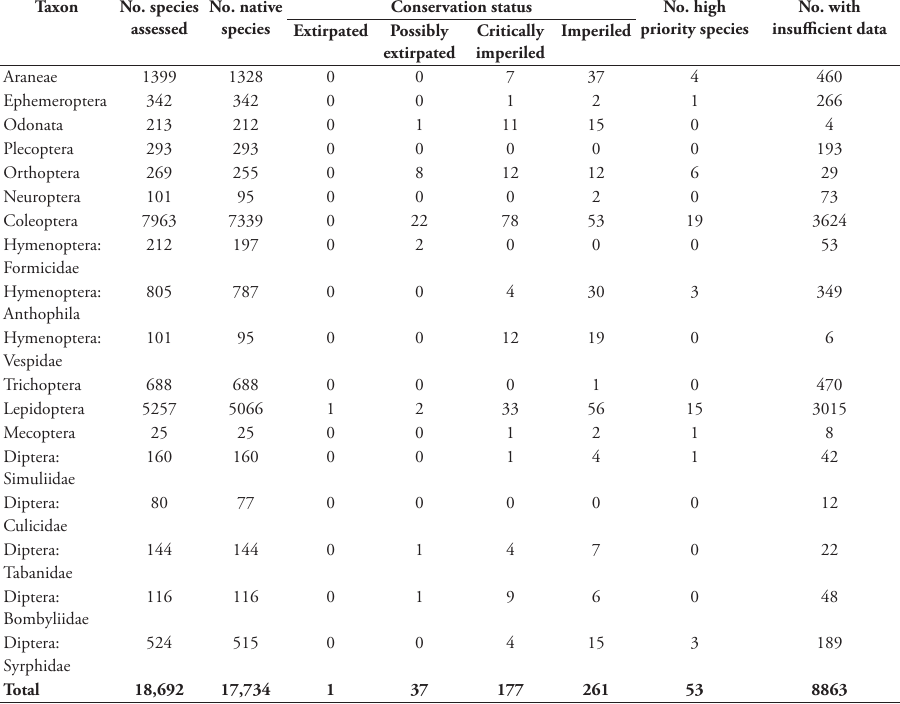
Table 4. Number of species of terrestrial arthropods and their conservation status as assessed by the Ca- nadian Endangered Species Conservation Council’s National General Status Working Group in its Wild Species 2015 report (CESCC